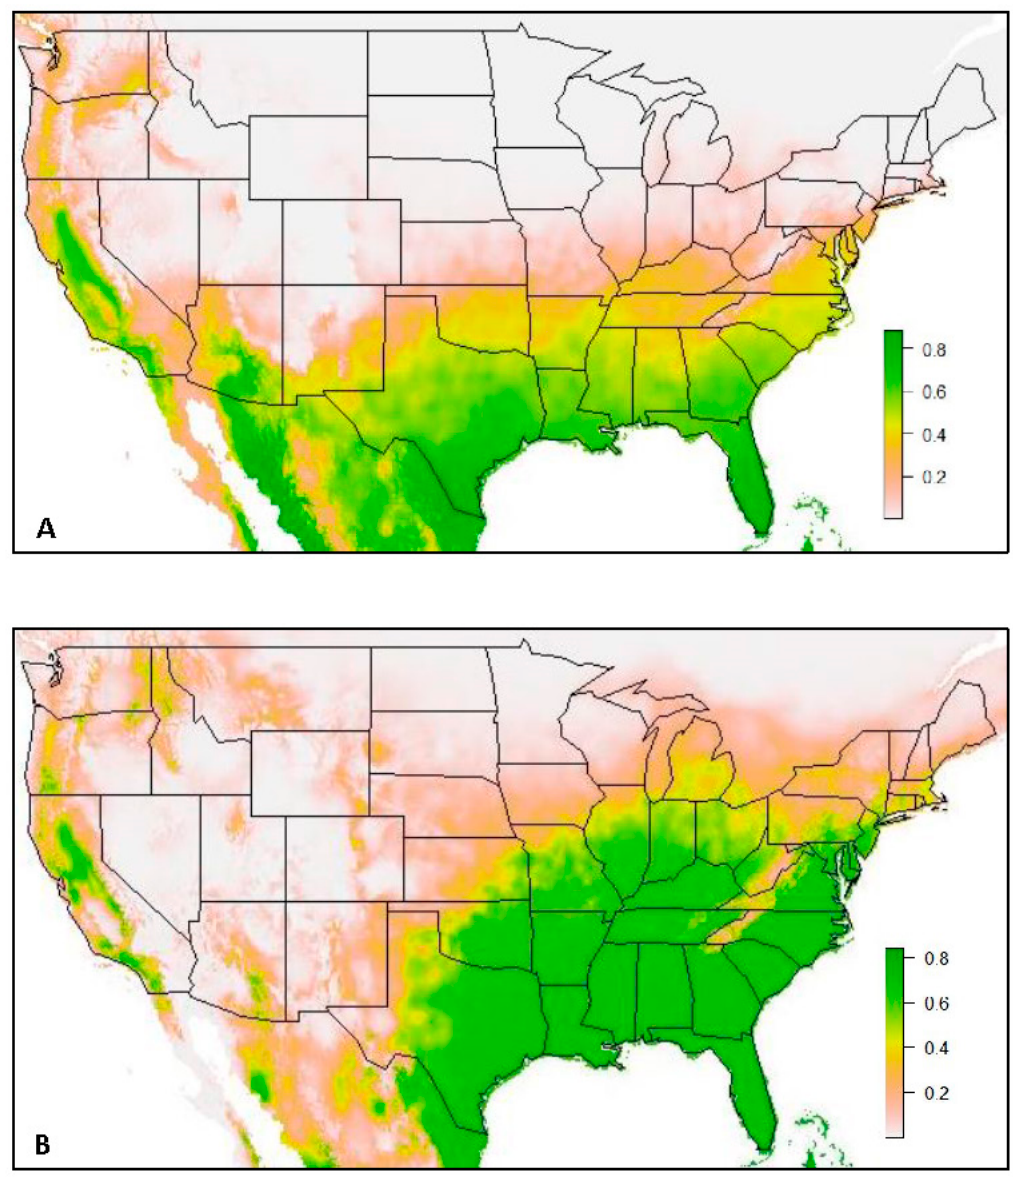
Figure 1. ( A ) Model 1a: Species distribution model of Ae. aegypti , and ( B ) Model 1b: Species distribution model of Ae. albopictus , both using all occurrence records from 1960–2014 (Kraemer et al. 2015b database) and records obtained by VZL personnel in Texas during 2016 and 2017. Green coloration indicates areas of high predicted habitat suitability (suitability ≥ 0.6), with darker green indicating areas with highest habitat suitability (suitability ≥ 0.8), yellow coloration indicates moderate habitat suitability (suitability = 0.4–0.6), tan coloration indicates low habitat suitability (suitability = 0.2–0.4) and white to light tan coloration indicates extremely low habitat suitability (suitability = 0.0–0.2).